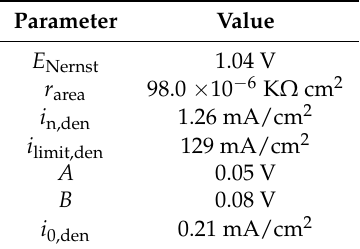
Table 1. PEMFC single cell parameters (from Refs.